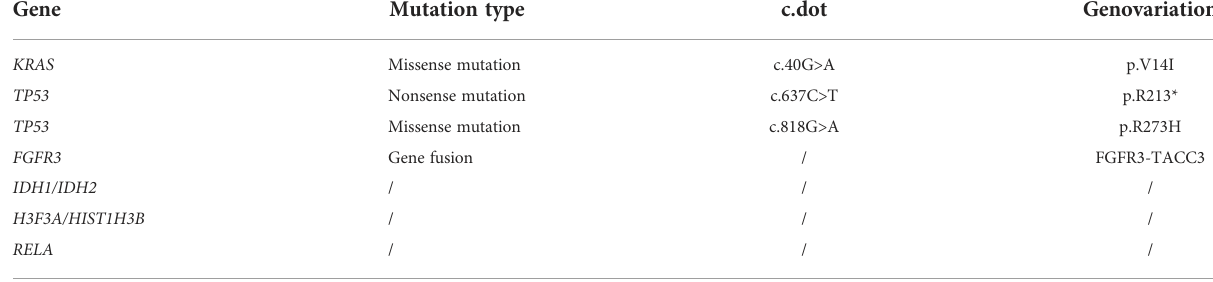
TABLE 1 NGS gene mutation pro fi ling in lung specimen.